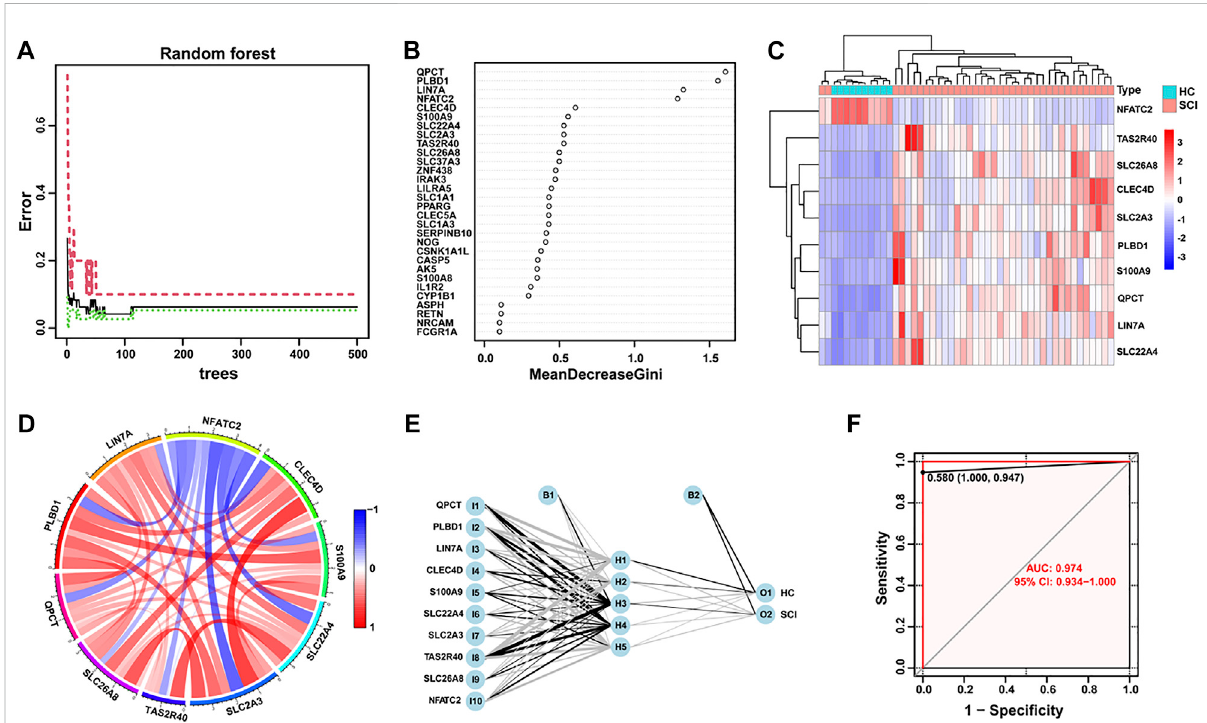
Random forest screening of genes and construction of neural networks. (A) The changes of error rate with the different number of decision treesinrandomforest.Thenumberoftreesisshowninx-axis,theerrorrateiscalculatedinthey-axis. (B) Importancelevelsofgeneswerecalculated andrankedusingGinicoef fi cientmethodinrandomforestalgorithm.Thex-axisindicatestheGinicoef fi cient,andthey-axisshowsthegenesymbol. (C) A heatmap with unsupervised clustering shows SCI and healthy control samples could be well distinguished by 10 key DEGs. Red color representsgeneswithhighexpressionintheSCIgroup,bluecolorrepresentsgeneswithlowexpression. (D) TheCircosplotshowsthecorrelationof the expression levels of the 10 key DEGs. The colors correspond to the direction of correlation, with red indicating positive relationships and blue indicatingnegativecorrelations. (E) Visualizationofaneuralnetworkmodel,while10keyDEGsareusedasinputlayer. (F) TheROCcurvere fl ectsthe accuracy of the neural network diagnostic